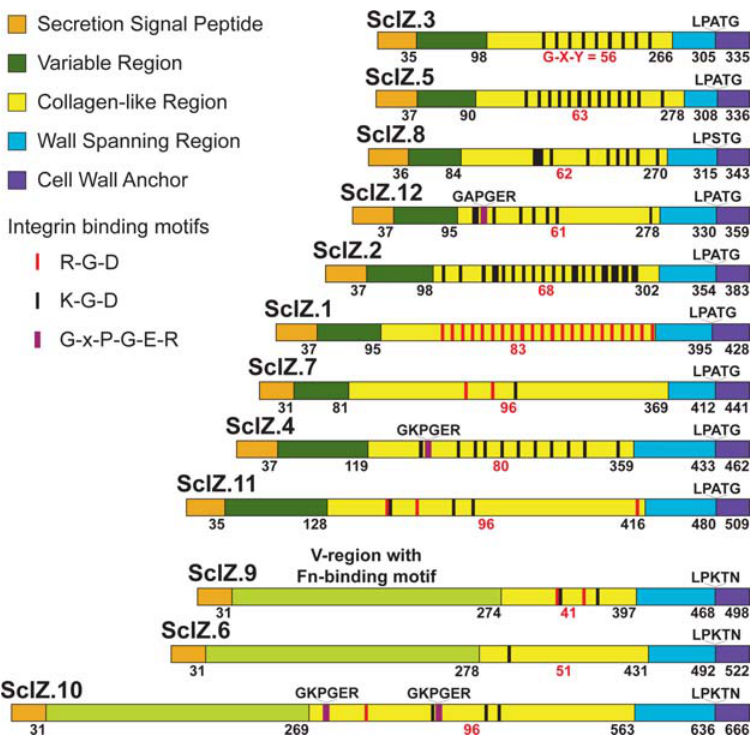
Figure 6. Schematic of collagen-like proteins . Illustrated are 12 inferred proteins with collagen structural motifs encoded by the MGCS10565 genome. These proteins are composed of the following domains (from amino- to carboxy-terminus): SSP, secretion signal peptide; V, variable region; CL, collagen-like region, W, a proline-rich putative cell wall spanning region, and finally a tripartite cell wall anchor. Numbers in black below the schematics are the last amino acid residue of each the respective regions. The number of contiguous Gly-Xxx-Yyy repeats composing the CL-regions are given in red. Sites within the CL-regions matching integrin recognition sequences RGD and KGD are indicated by red and black bars, respectively. Prokaryotic analogs (GxPGER) of human collagen sequences mediating high-affinity integrin binding, are indicated by violet bars. CLPs 6, 9, and 10 have V-regions with fibronectin-binding domains.